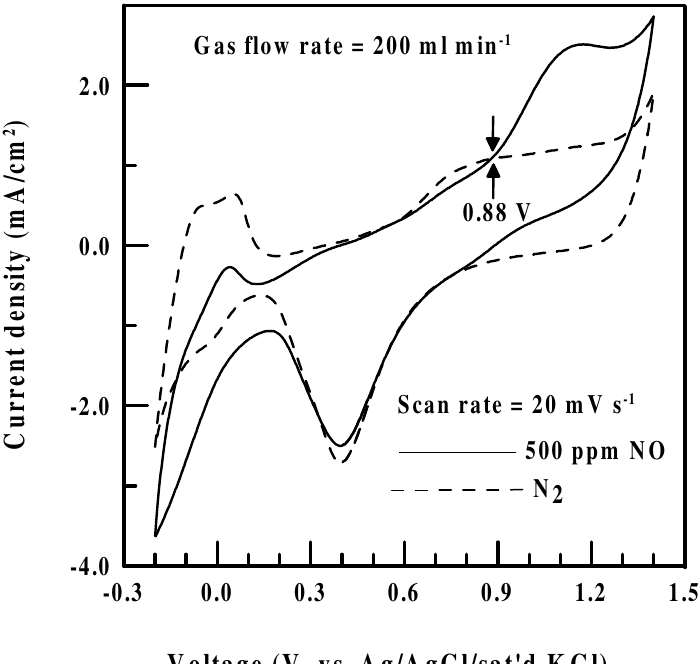
Figure 3. Typical CVs for a Pt/Nafion (cid:226) electrode run at 20 mV/sec. Gas phase: ( (cid:190)(cid:190) ) 500 ppm NO; ( - - - ) pure N . Solution phase: 0.5 M H 2 The typical CVs of a Pt/Nafion (cid:226) electrode in contact with 0.5 M H N (dotted line) and 500 ppm NO (solid line) gases, are shown in Fig. 3. The results were obtained 2